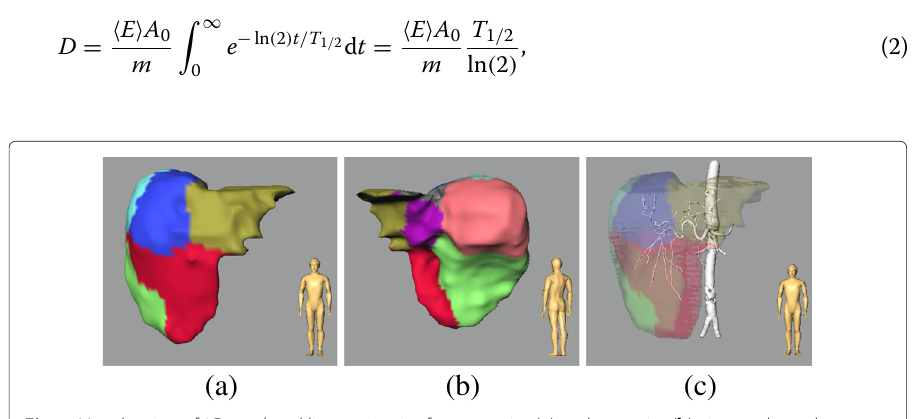
Fig. 1 Visualization of 3D rendered liver territories from anterior ( a ) and posterior ( b ) view and translucent territories with opaque visualization of the arterial vessel system ( c